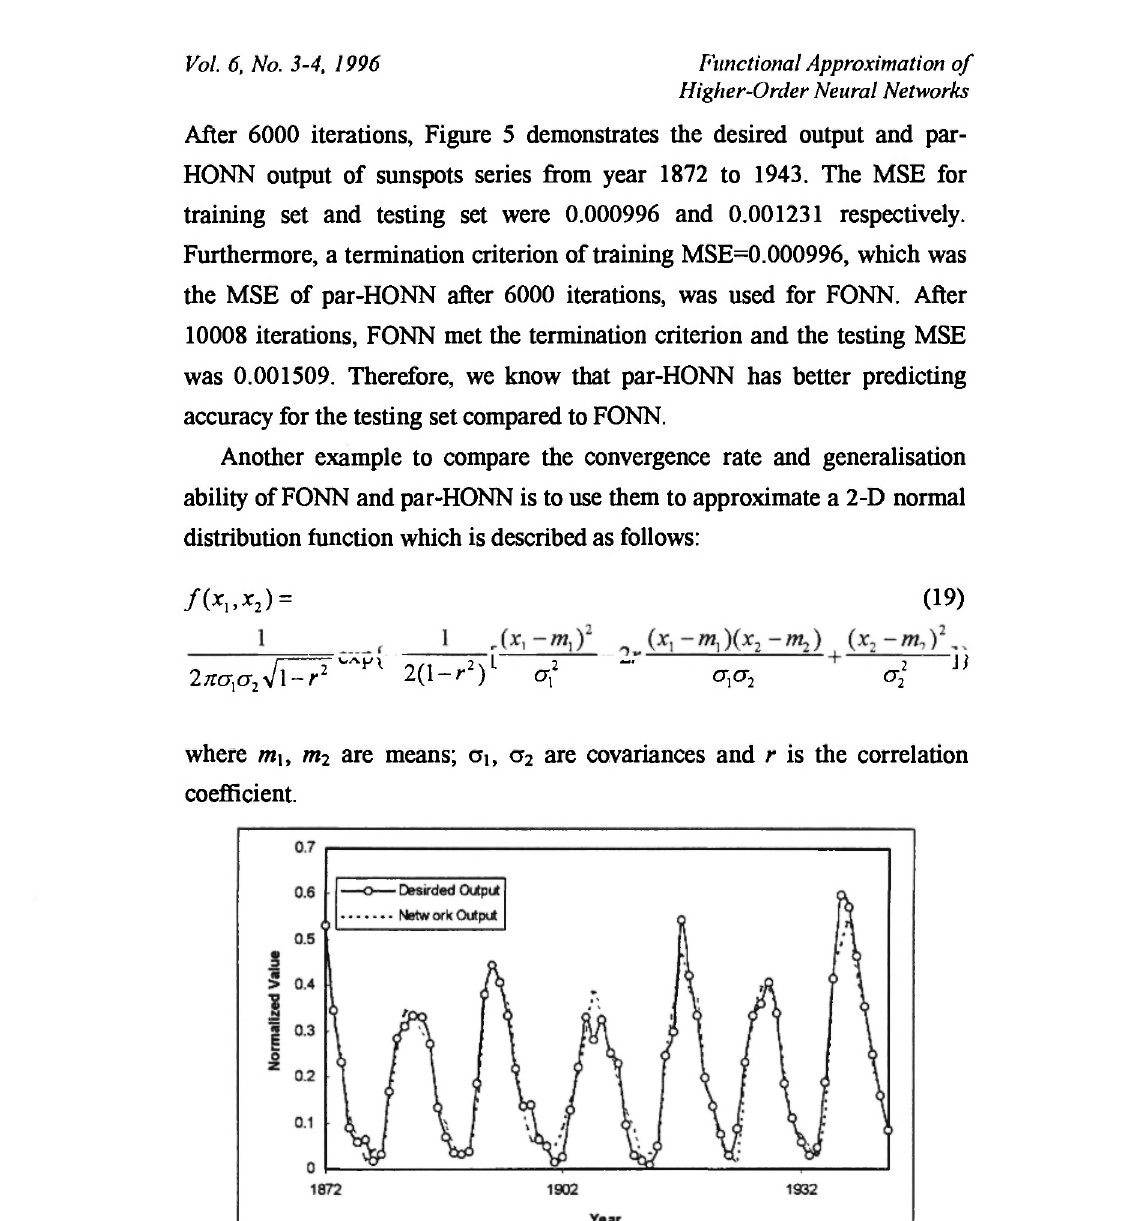
Fig. 5: The desired output and par-HONN output of sunspots series from the year 1872 to 1943 after 6000 iterations. From year 1872 to 1931 is the training set, while from year 1932 to 1943 is the testing